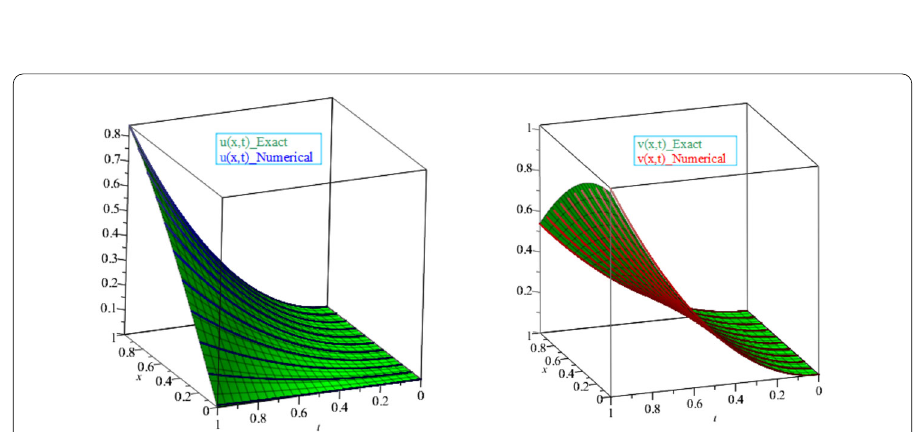
Figure 2 The plots of approximate solutions and exact solutions of u ( x , t ) and v ( x , t )for Example 5.1 with the noisy data